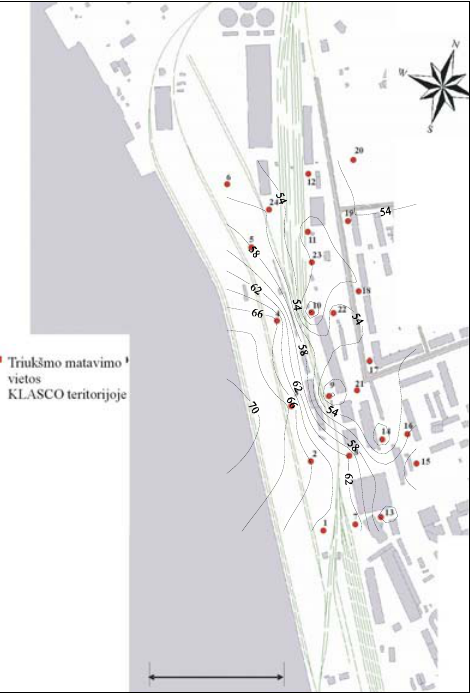
Fig 10. Dispersion of reciprocal noise level in the day in October